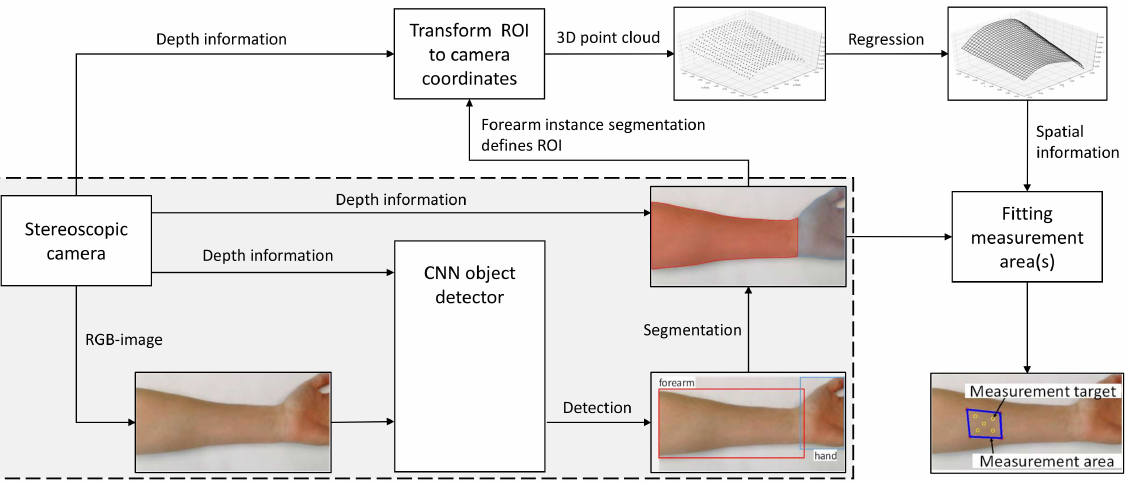
Figure 2. Proposed concept for segmenting arm areas and its further context in the image processing